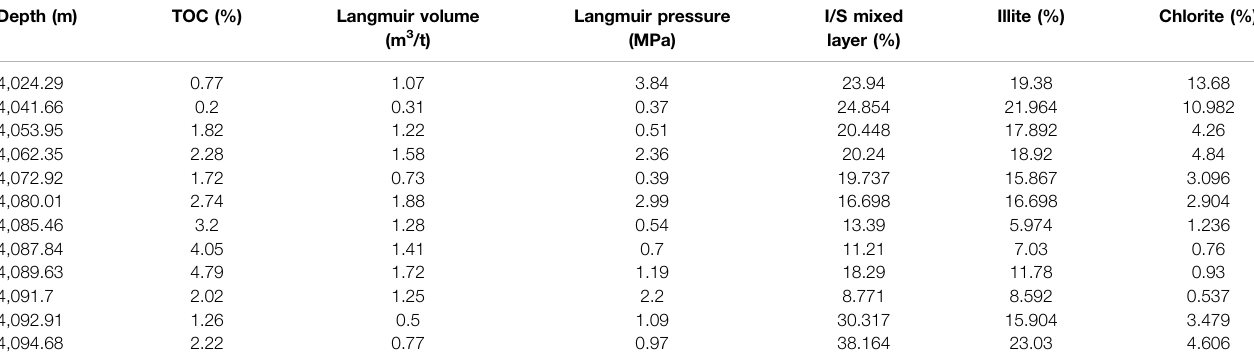
TABLE 3 | Results of core sample analysis for TOC content, Langmuir Volume, Langmuir Pressure and clay mineral composition. Depth (m) TOC